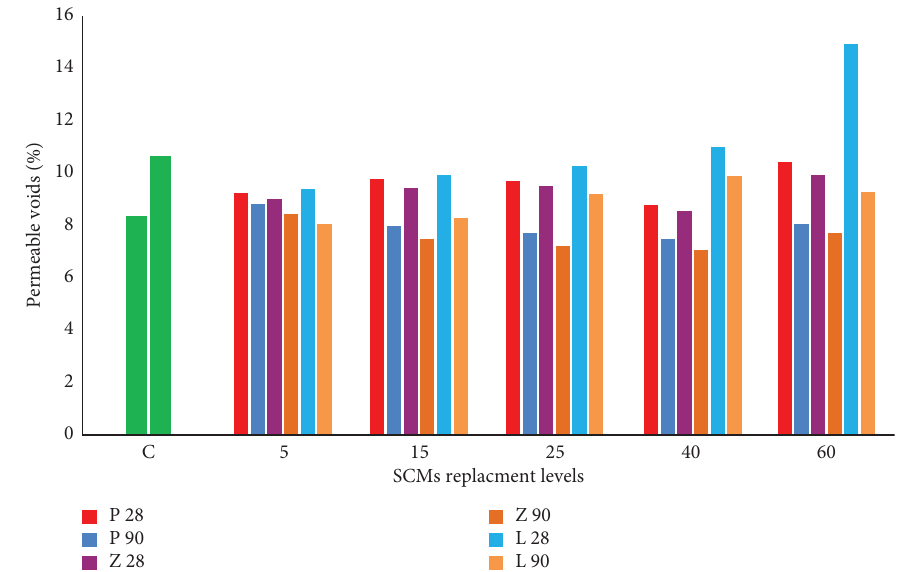
Figure 8: Permeable voids of the diferent mixtures at the age of 28 and 90days.